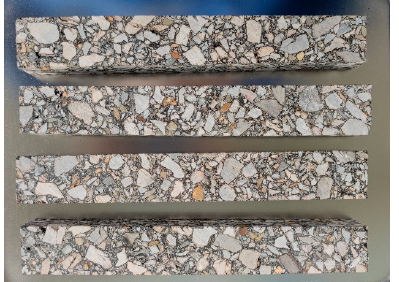
Figure 2. Asphalt mixture beams of AC-25.